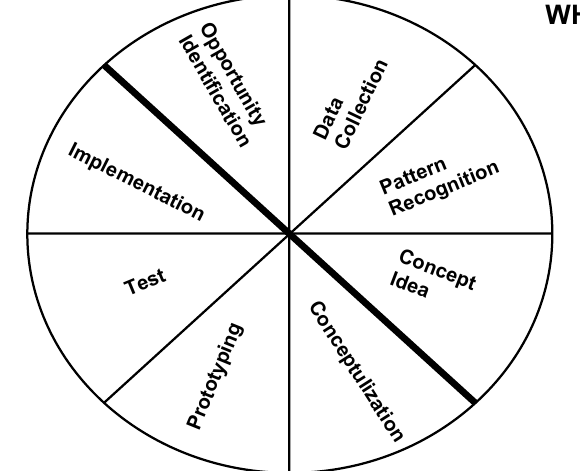
Fig. 1. The Innovation Wheel - cited from Wise and Høgenhaven (2008, p.